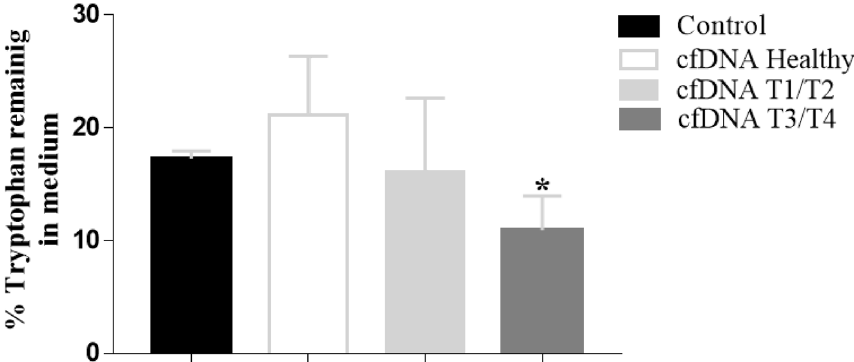
Figure 4. Treatment of RWPE-1 cells with T3/T4 patient cfDNA stimulated the uptake of tryptophan from the medium. Twenty nanograms of cfDNA were incubated with 1 × 10 5 cells in medium containing 5 mM tryptophan. The tryptophan levels in medium were determined by metabolomic analysis. The medium of cells not-treated with cfDNA was used as a control. Data are reported as means ± SD of tryptophan levels (%). (*p < 0.05; Dunn’s multiple comparison test).